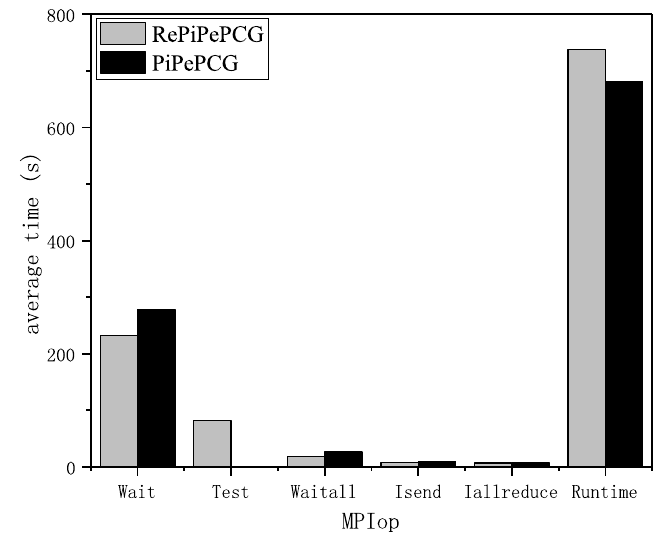
Figure 17. Comparison of average MPI cost in solving the cavity case at 768